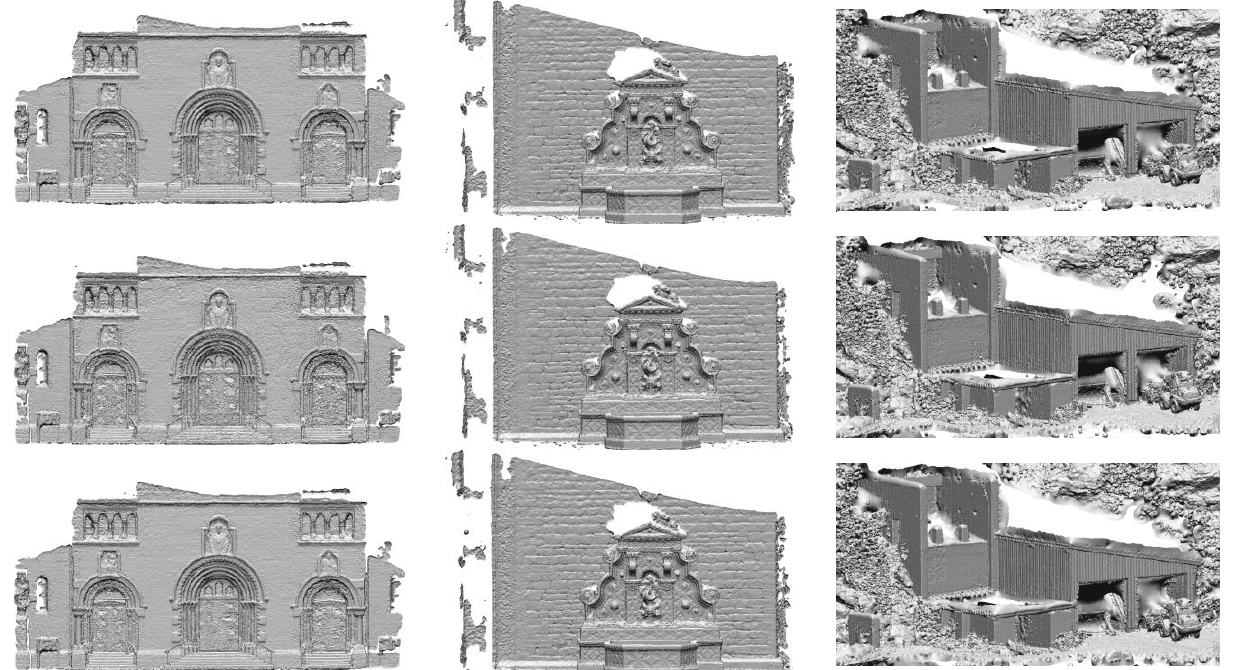
Figure 6. Meshed surfaces with normal shading. Datasets from left to right: HerzJesuP25, FountainP11 and IF15D800E. In top down order: symmetric cost function, accumulated cost function, PhotoScan. The corresponding orientation data and undistorted images have been used to reconstruct the surfaces with SURE, using identical settings. While differences are marginal in general, the accumulated cost function produces higher noise in some cases, as can be seen at the example of